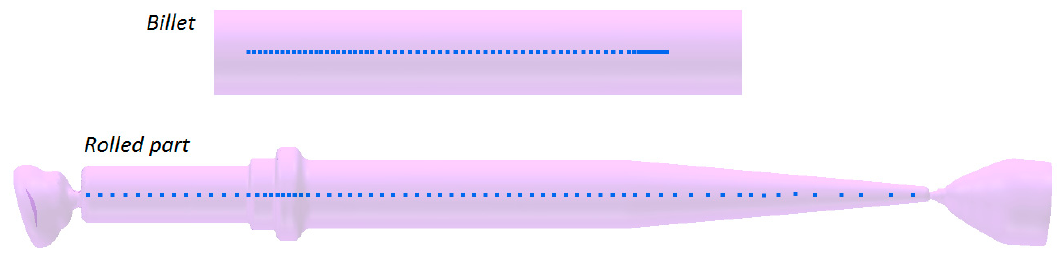
Figure 17. Location of the virtual sensors in the billet and the rolled part, used for monitoring the state of stress and strain.